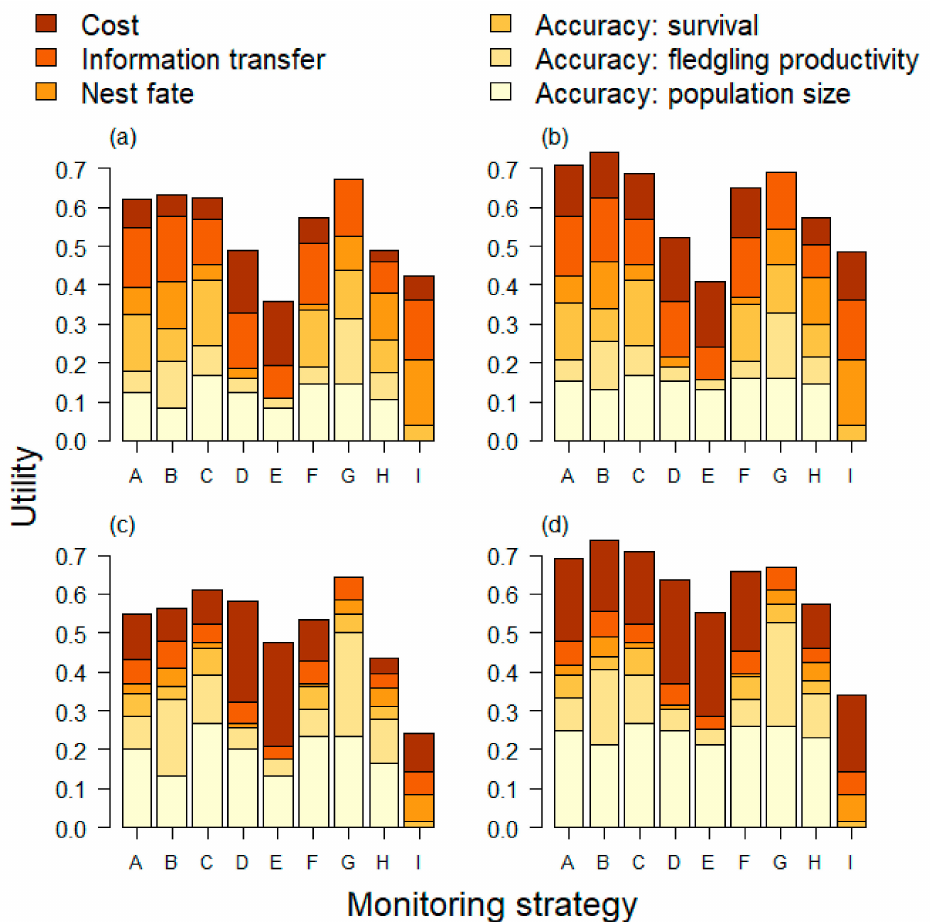
Figure 6. Summary of multi-attribute utility analysis. ( a ) The “equal” weight scenario (Table 1) with a risk neutral decision maker. ( b ) The “equal” weight scenario with a risk averse decision maker. ( c ) “More on mandates” weight scenario (Table 1) with a risk neutral decision maker. ( d ) “More on mandates” with a risk averse decision maker. In general, risk management shown in ( b ) and ( d ) changes the preferred monitoring strategy from G, the most expensive strategy, to B; strategies A and C are also competitive when risk management is added. The accuracy of population size and fledgling productivity (two lightest shades) are important for monitoring two recovery criteria for the species. See Table 2 for descriptions of the strategies and Supplementary Materials 3 for